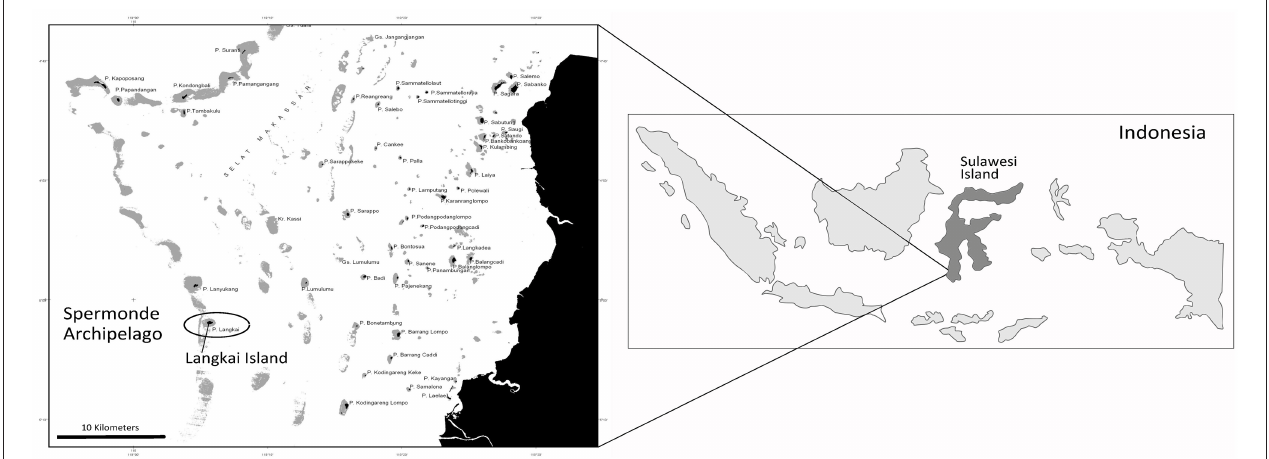
FIGURE 1 | Langkai Island, South Sulawesi,